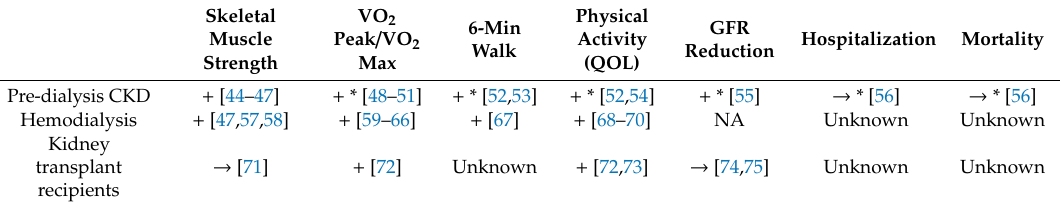
Table 1. Exercise therapy approach to patients with various stages of CKD.